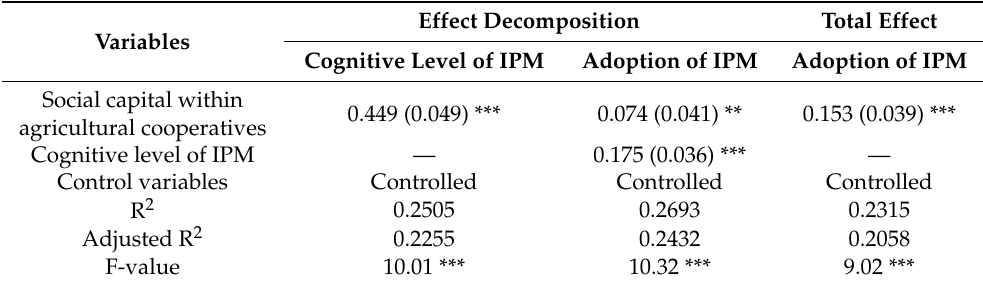
Table 4. The results of mediating effect estimation.